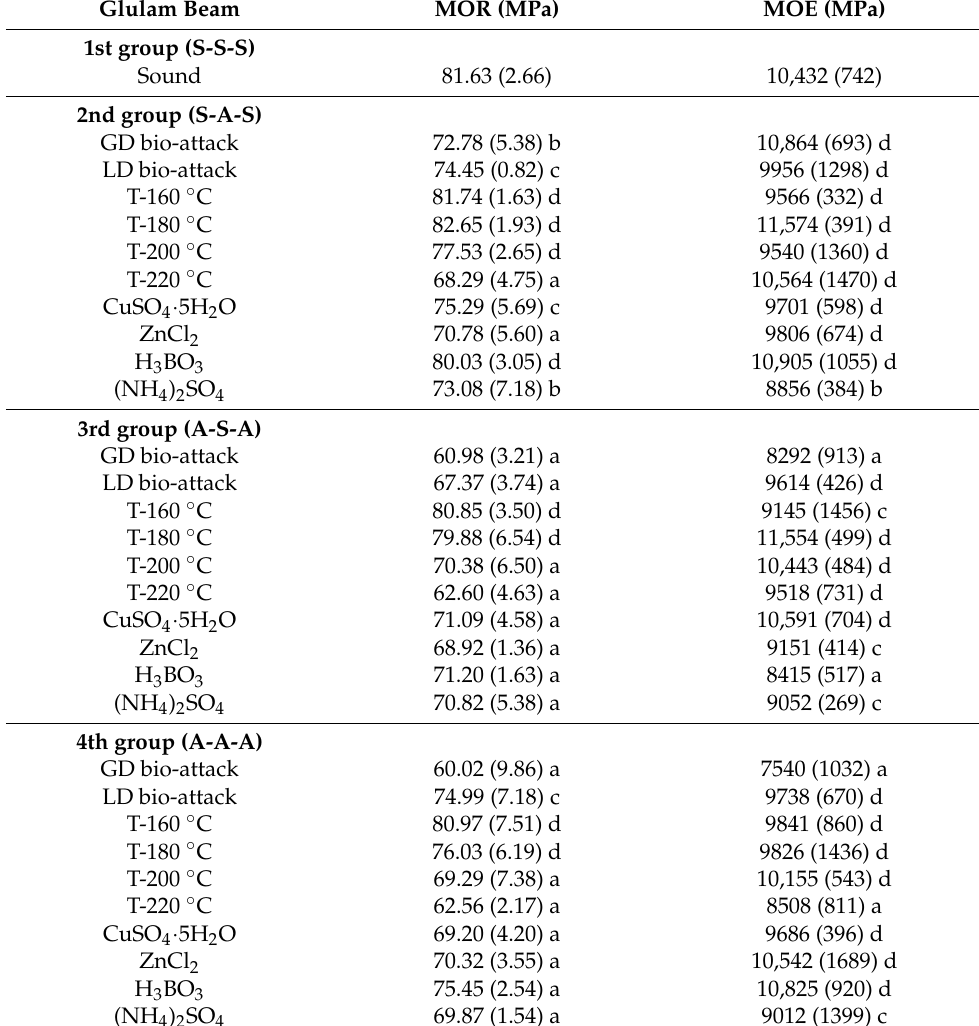
Table 1. The bending characteristics MOR and MOE of the three-layer glulam beams in the 1st, 2nd, 3rd and 4th groups (Figure 3) prepared from Norway spruce lamellas of type I and PUR glue (Figure